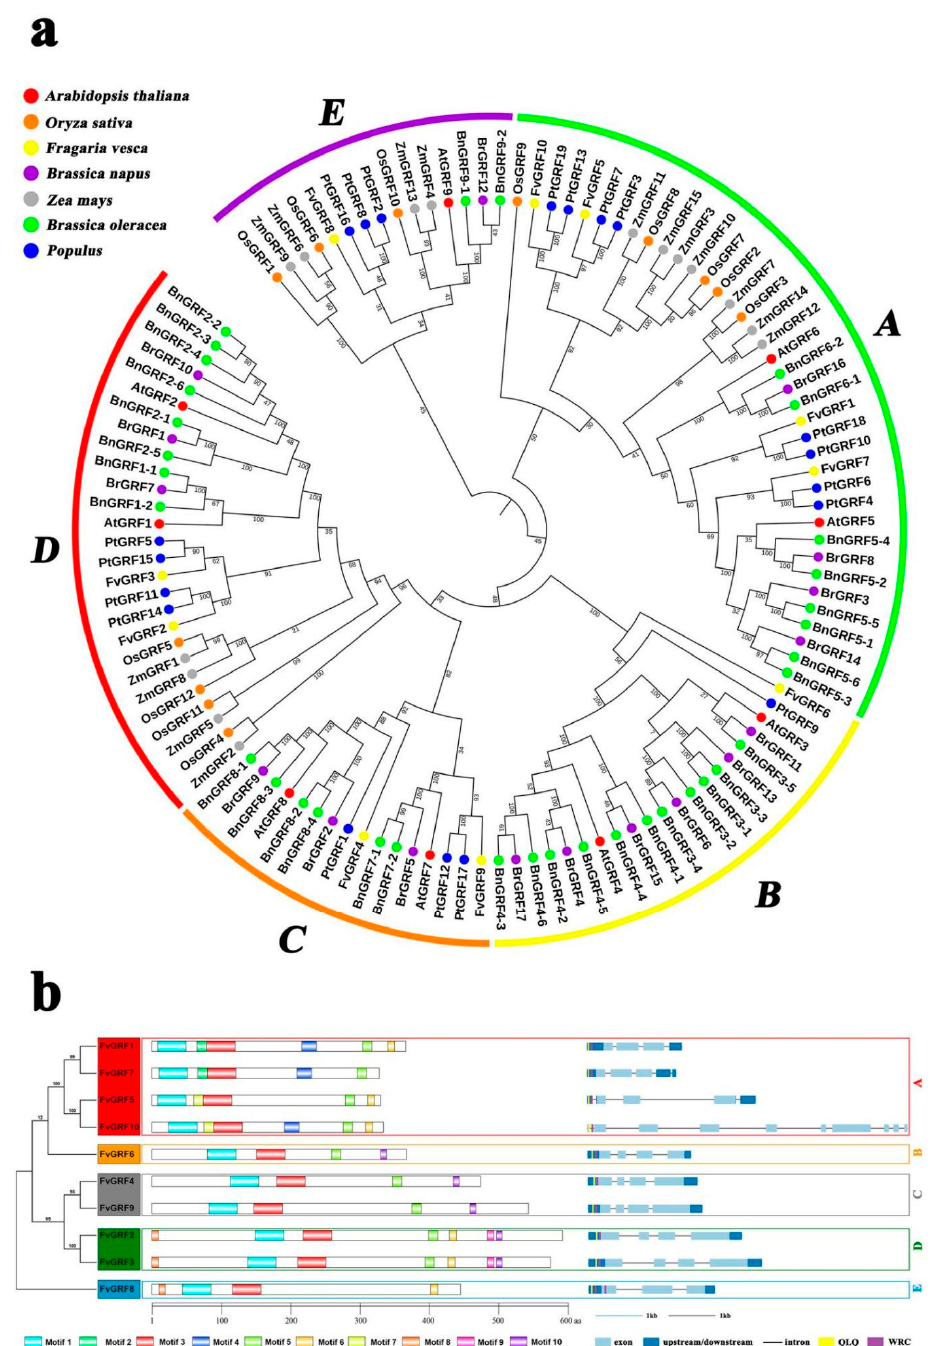
Figure 1. ( a ). Phylogenetic analysis of GRF proteins of Arabidopsis, rice, woodland strawberry, poplar, maize, Chinese cabbage, and rapeseed. The full-length amino acid sequences of GRF proteins from Arabidopsis ( AtGRF ), rice ( OsGRF ), woodland strawberry ( FvGRF ), poplar ( PtGRF ), maize ( ZmGRF ), Chinese cabbage ( BrGRF ), and rapeseed ( BnGRF ) were aligned using ClustalX. The phylogenetic tree was constructed using the maximum likelihood method with 1000 bootstrap replicates using MEGA6.0. The branches are colored to indicate GRF subfamilies. ( b ). Structural analysis of strawberry GRF protein. The protein domains of the strawberry GRF genes are shown on the left and are denoted by rectangles with different colors. The exon–intron organization is shown on the right, with exons and introns represented by light blue rectangles and black lines, respectively; UTRs are indicated by dark blue rectangles. The sequence of yellow boxes and purple boxes code the QLQ domain and WRC domain, respectively. The red, orange, gray, green, and blue rectangles are used to cluster the genes into the A, B, C, D, and E subfamilies,